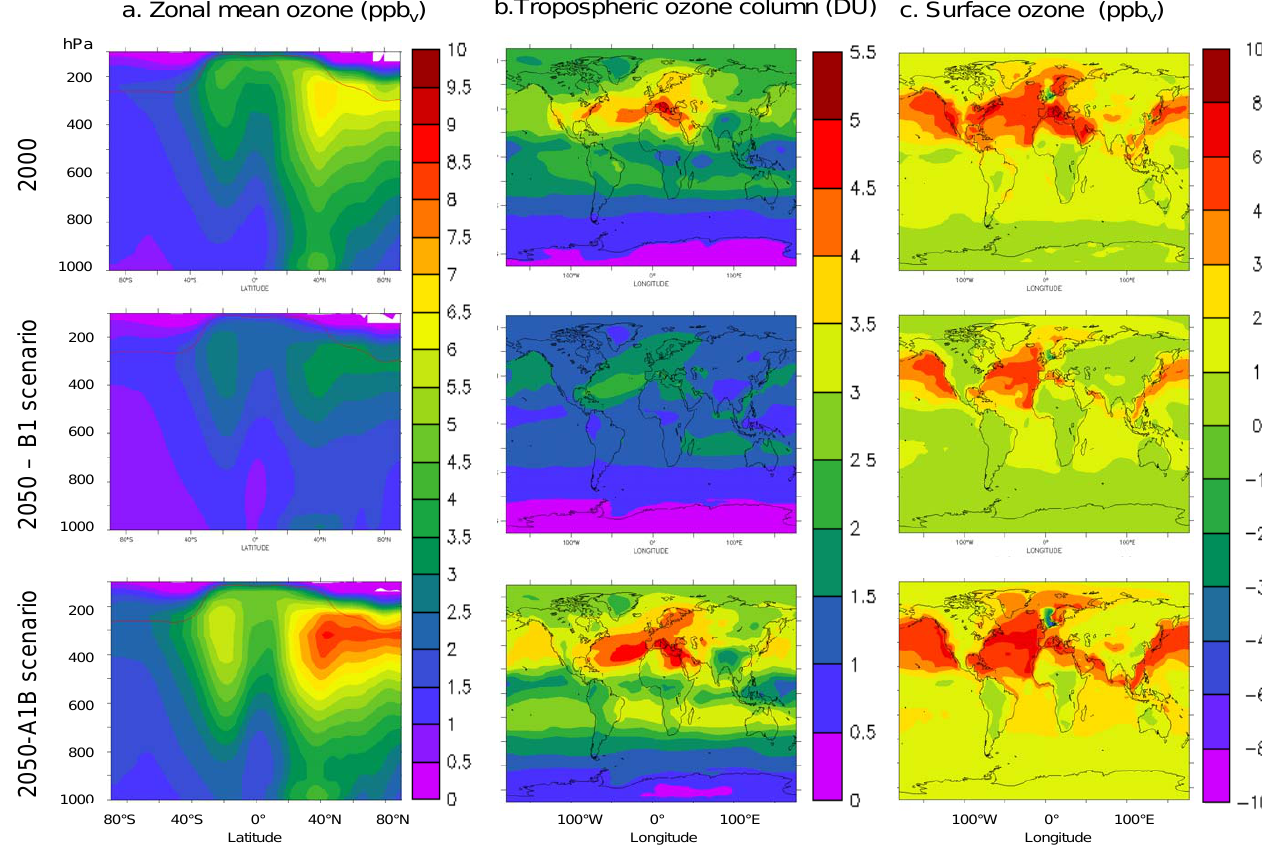
Fig. 1. Total (aircraft, shipping and road traffic) transport up-scaled (5% decrease effect × 20) perturbation in July for (a) zonal mean ozone ( 1 ppb v ) , (b) tropospheric ozone column ( 1 DU), and (c) surface ozone ( 1 ppb v ) , due to 2000 (A experiment), 2050 B1 scenario (B experiment) and 2050 A1B scenario (C experiment) emissions (the solid line on plots a indicates the tropopause).